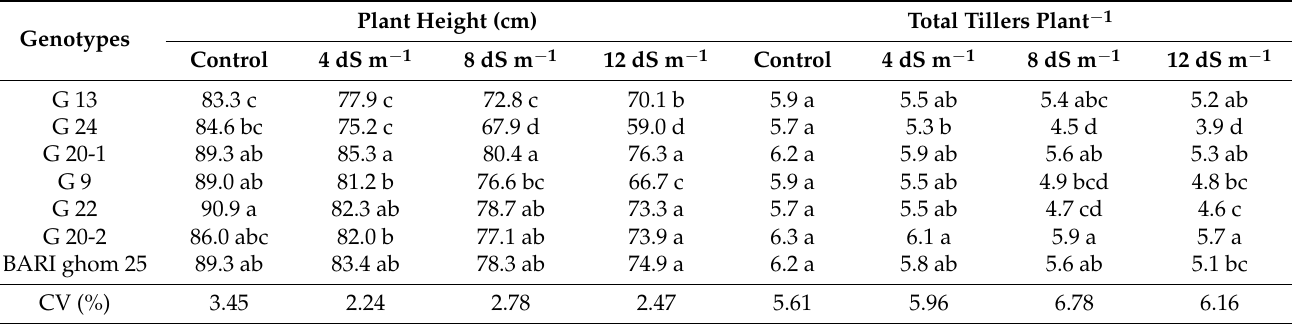
Table 1. Plant height and total tillers of wheat genotypes under different salinity levels.